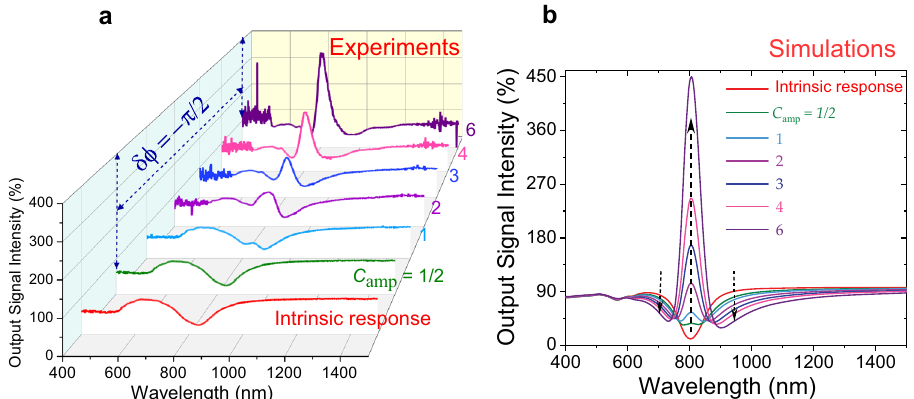
Fig. 5 Broadband transmission enhancement of the signal beam in the plasmon resonance band of the metasurface. a Experimental output signal intensity curves as a function of C amp with phase difference of δϕ = − π /2 in comparison to the intrinsic response of the metasurface. b 2D representation of the transmitted output signal intensity curves as a function of the amplitude of the control beam ( C amp ) with a phase difference of δϕ = − π /2 in comparison to the intrinsic response of the metasurface when there is no polarizer and phase delay component included in the